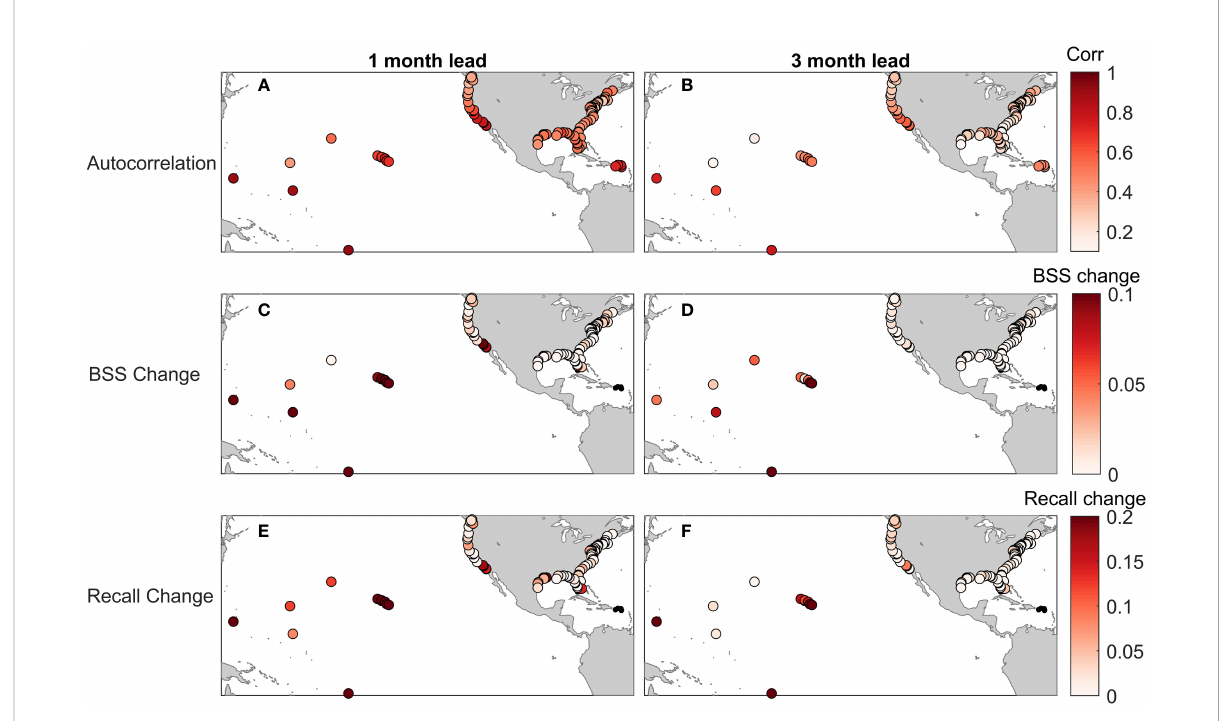
FIGURE 8 Shown are the autocorrelation of monthly MSL anomalies at both 1 and 3 months of lead (A, B) and the change in BSS (C, D) or recall (E, F) when using the monthly MSL anomaly for the prediction of HTF days at either one- or three-months lead. Small black dots in the BSS and Recall plots (Caribbean and Florida Keys) indicate less than 10 HTF days occurred over the 1997 – 2019